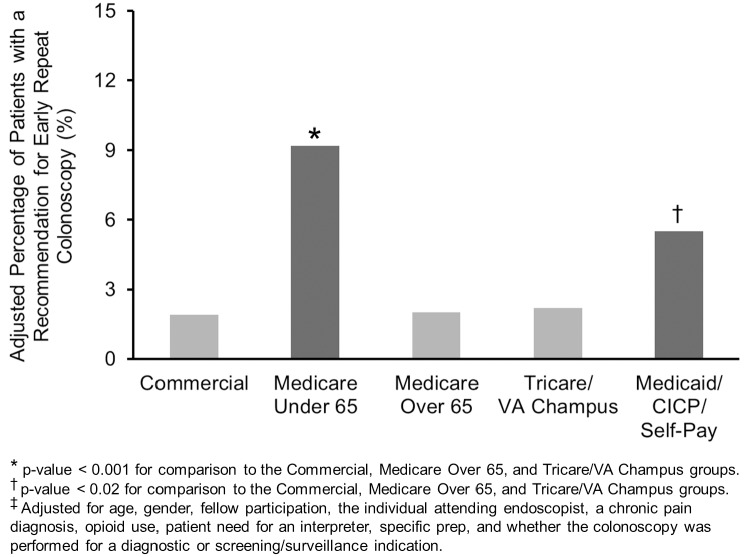
A Higher Percentage‡ of Medicare Patients Under 65 and Medicaid/CICP/Self-Pay Patients Received a Recommendation for an Early Repeat Colonoscopy.